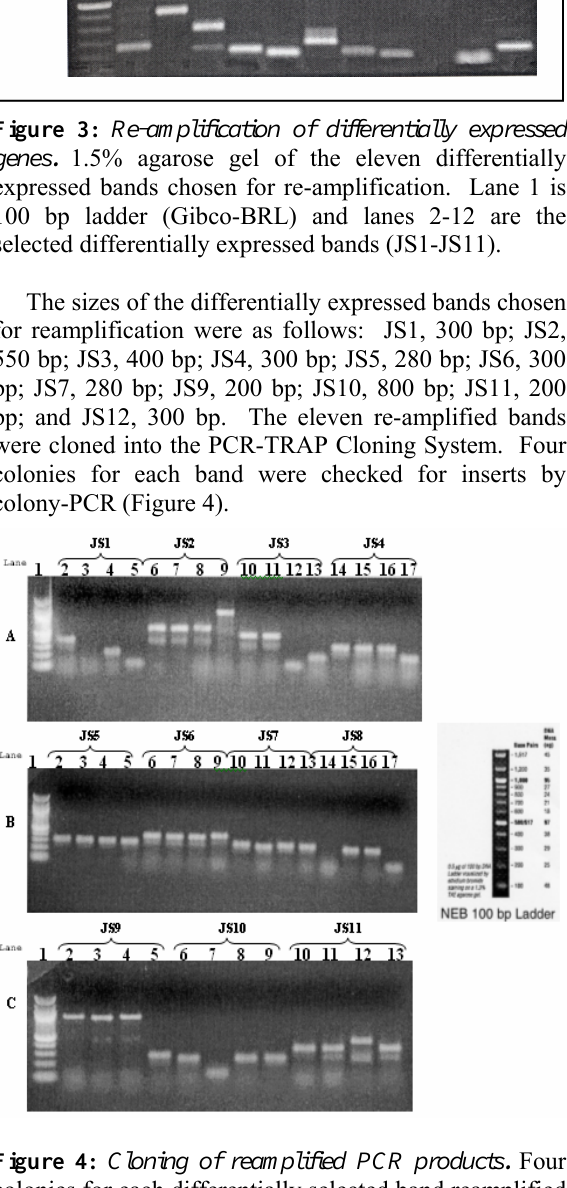
Figure 4: Cloning of reamplified PCR products. Four colonies for each differentially selected band reamplified were checked for inserts by colony PCR. 100 bp ladder (NEB) was used as a size standard in lanes 1A, 1B and 1C for gels. JS represents selected differentially bands from normal and UVB irradiated corneal epithelial